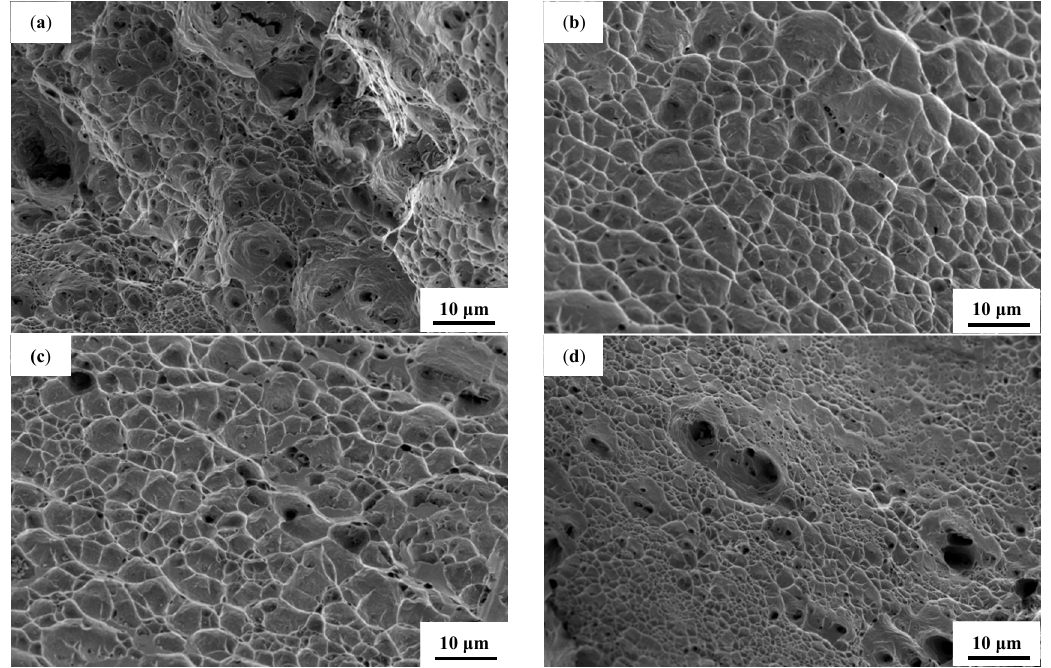
Figure 7. Fracture surface morphology of Fe-25Mn-3Si-3Al-0.3Nb steel before and after cold rolling ( a ) solid solution; ( b ) after 30% deformation; ( c ) after 50% deformation; ( d ) after 70% deformation.